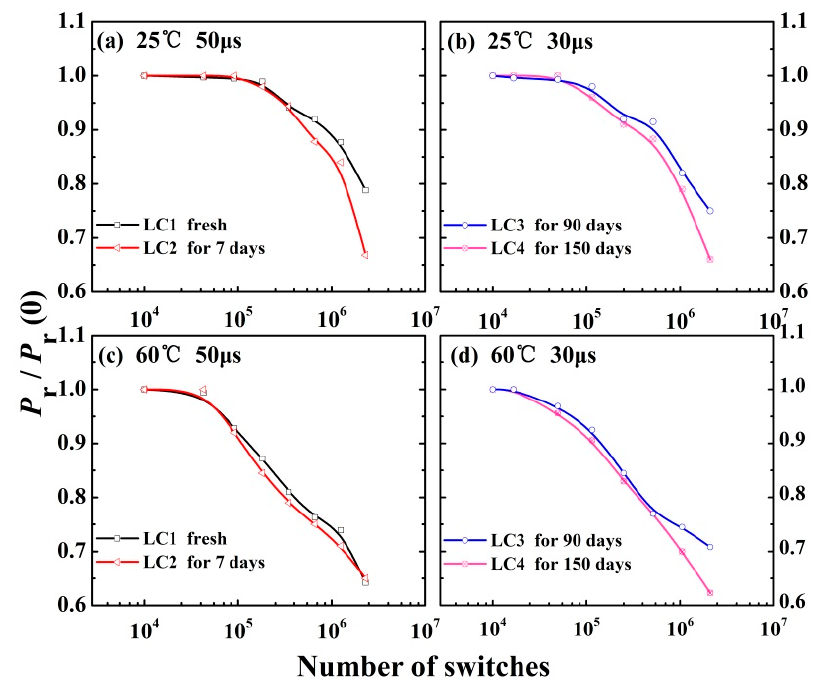
Figure 1. The polarization properties of P(VDF–TrFE) films stored in air for several days with 50 µ s applied voltage pulse width at 25 ◦ C ( a ) and 60 ◦ C ( c ). The polarization properties of P(VDF–TrFE) films stored in air for 90 or 150 days with 30 µ s applied voltage pulse width at 25 ◦ C ( b ) and 60 ◦ C ( d ). To further explore this result, a series of experiments were carried out, and the polar- ization properties of LC1–LC4 with different storage periods and testing temperatures are listed in Table 1. From Table 1, we can see that the initial remanent polarization ( P r ( BF ) ) of the sample decreased with the increase of storage period, and after being stored in air for 150 days, P r ( BF ) decreased by 24.4% both at 25 ◦ C and 60 ◦ C. Meanwhile, the relative remanent polarization reflects the polarization characteristics of ferroelectric thin film devices in the polarization switching process. Therefore, we pay more attention to the characteristics of relative remanent polarization in the process of polarization switching for the stability of